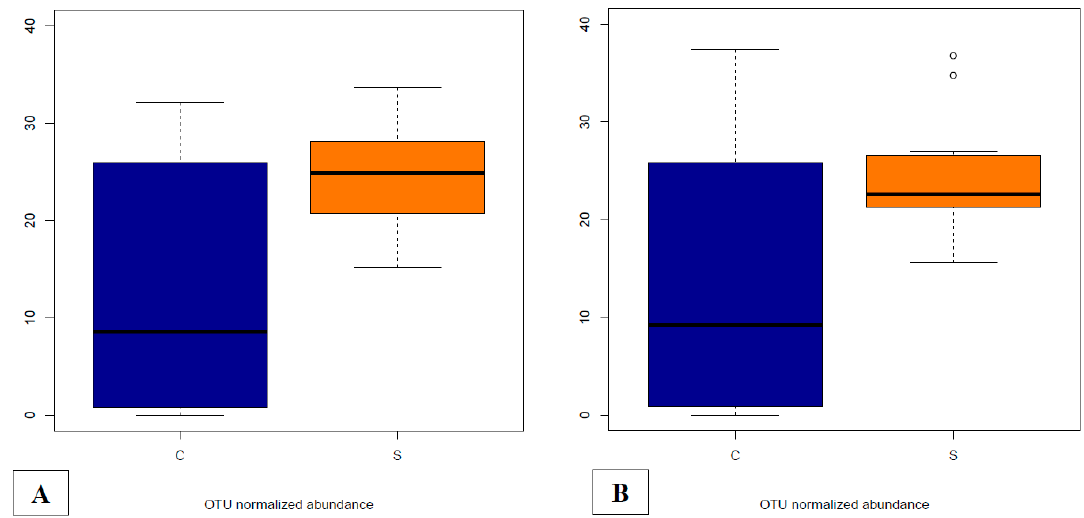
Figure 5. Abundances of F. prausnitzii on day 40 in fecal ( A ) and cecal ( B ) contents for each dietary treatment group (C = basal control diet, S = basal diet supplemented with Saccharomyces cerevisiae boulardii CNCM I-1079). Abundances were calculated as the addition of metagenomeSeq normalized for OTUs annotated as F. prausnitzii in the whole dataset (OTU IDs 589282, 157308, 158981, 158632 and New.ReferenceOTU11002).